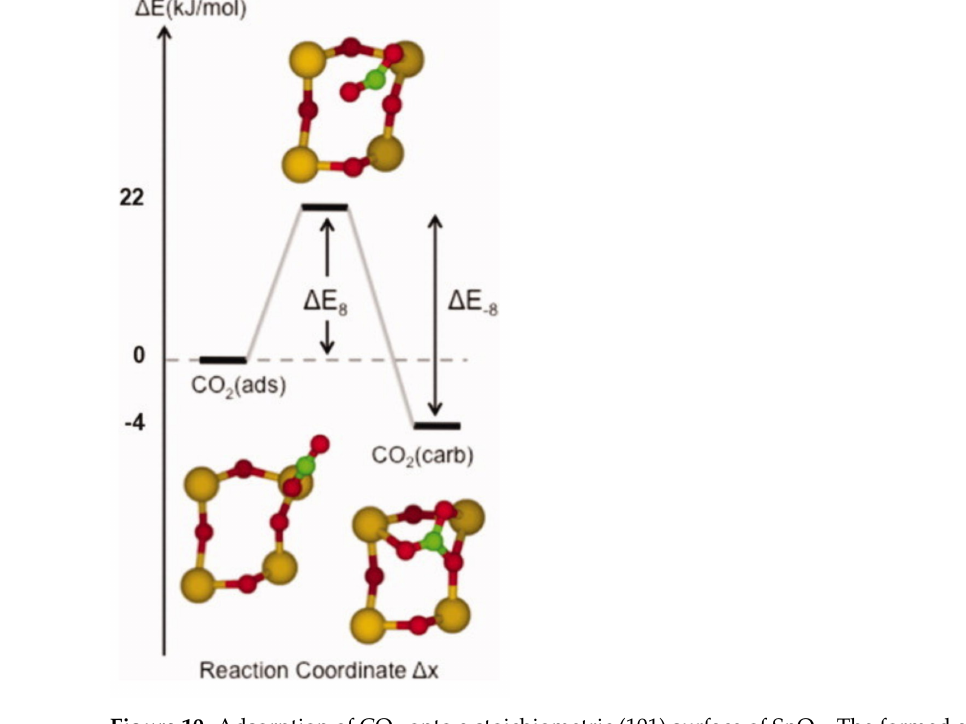
Figure 10. Adsorption of CO 2 onto a stoichiometric (101) surface of SnO 2 . The formed adsorbate is a tridentate carbonate-like species. Reproduced with permission from Reference